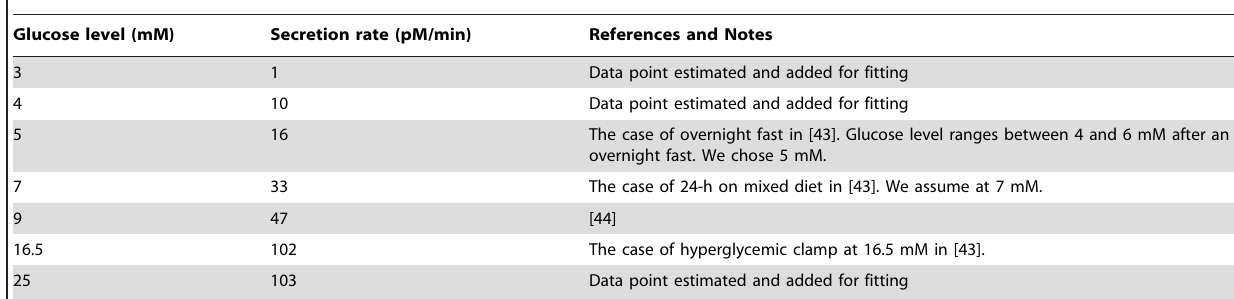
Table 1. Insulin secretion data rate and multiple glucose concentrations.